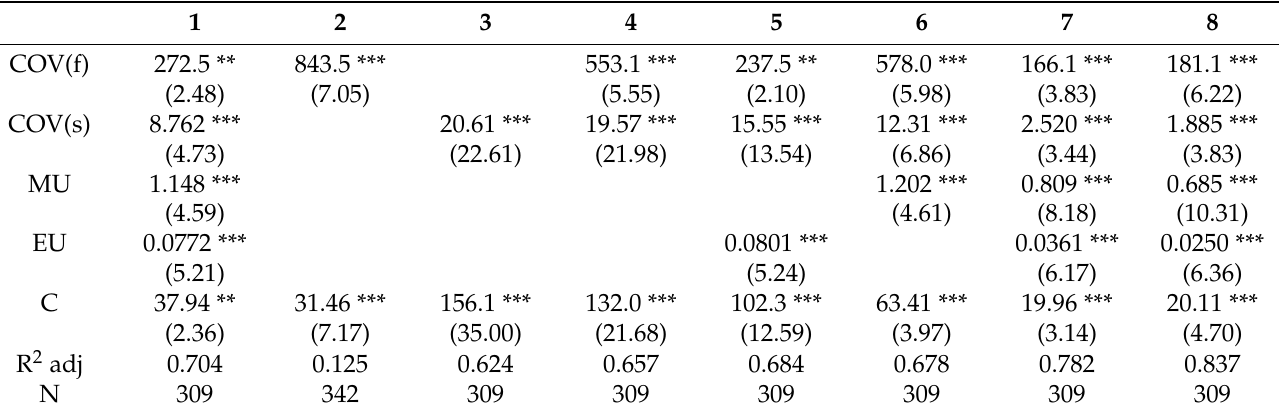
Table 4. COVID-19 death announcements and oil price volatility, North American